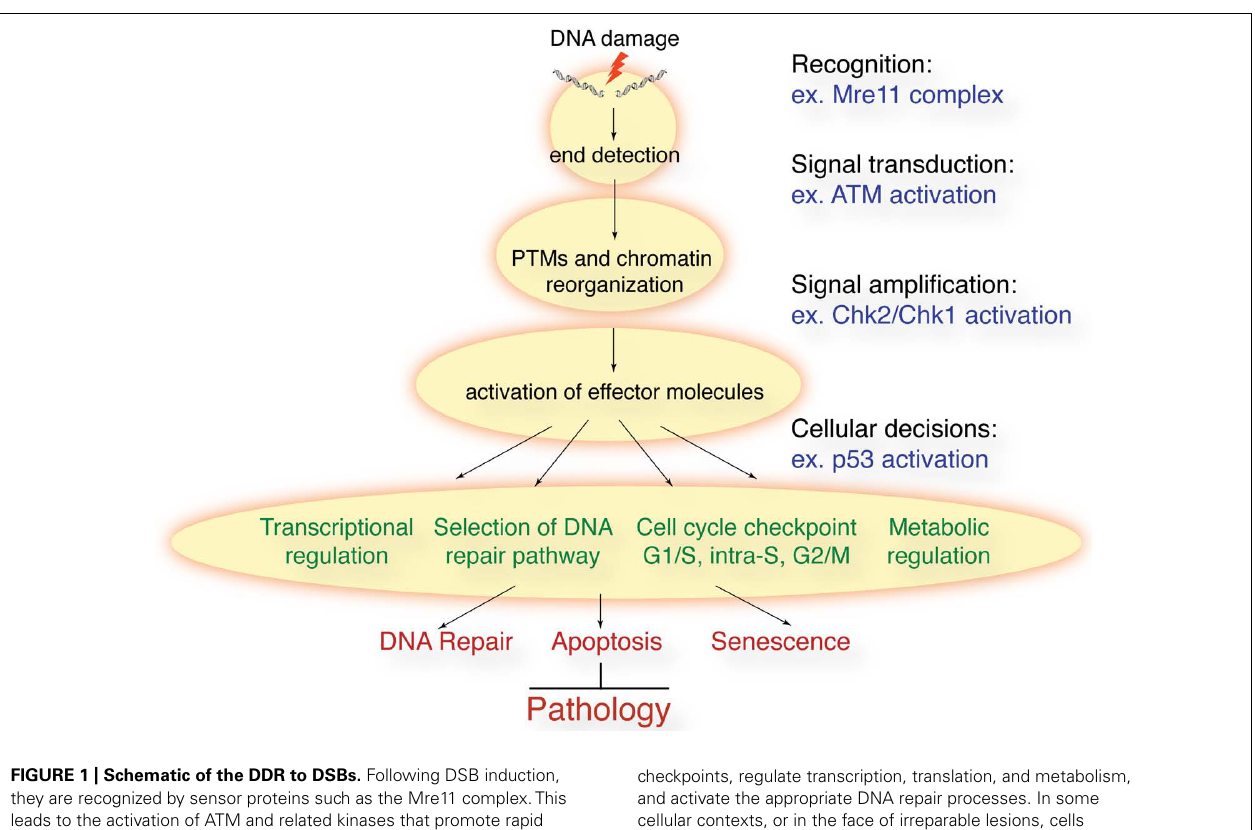
checkpoints, regulate transcription, translation, and metabolism, and activate the appropriate DNA repair processes. In some cellular contexts, or in the face of irreparable lesions, cells can activate apoptosis and senescence.The collective result is the prevention of genomic instability and the accompanying pathological